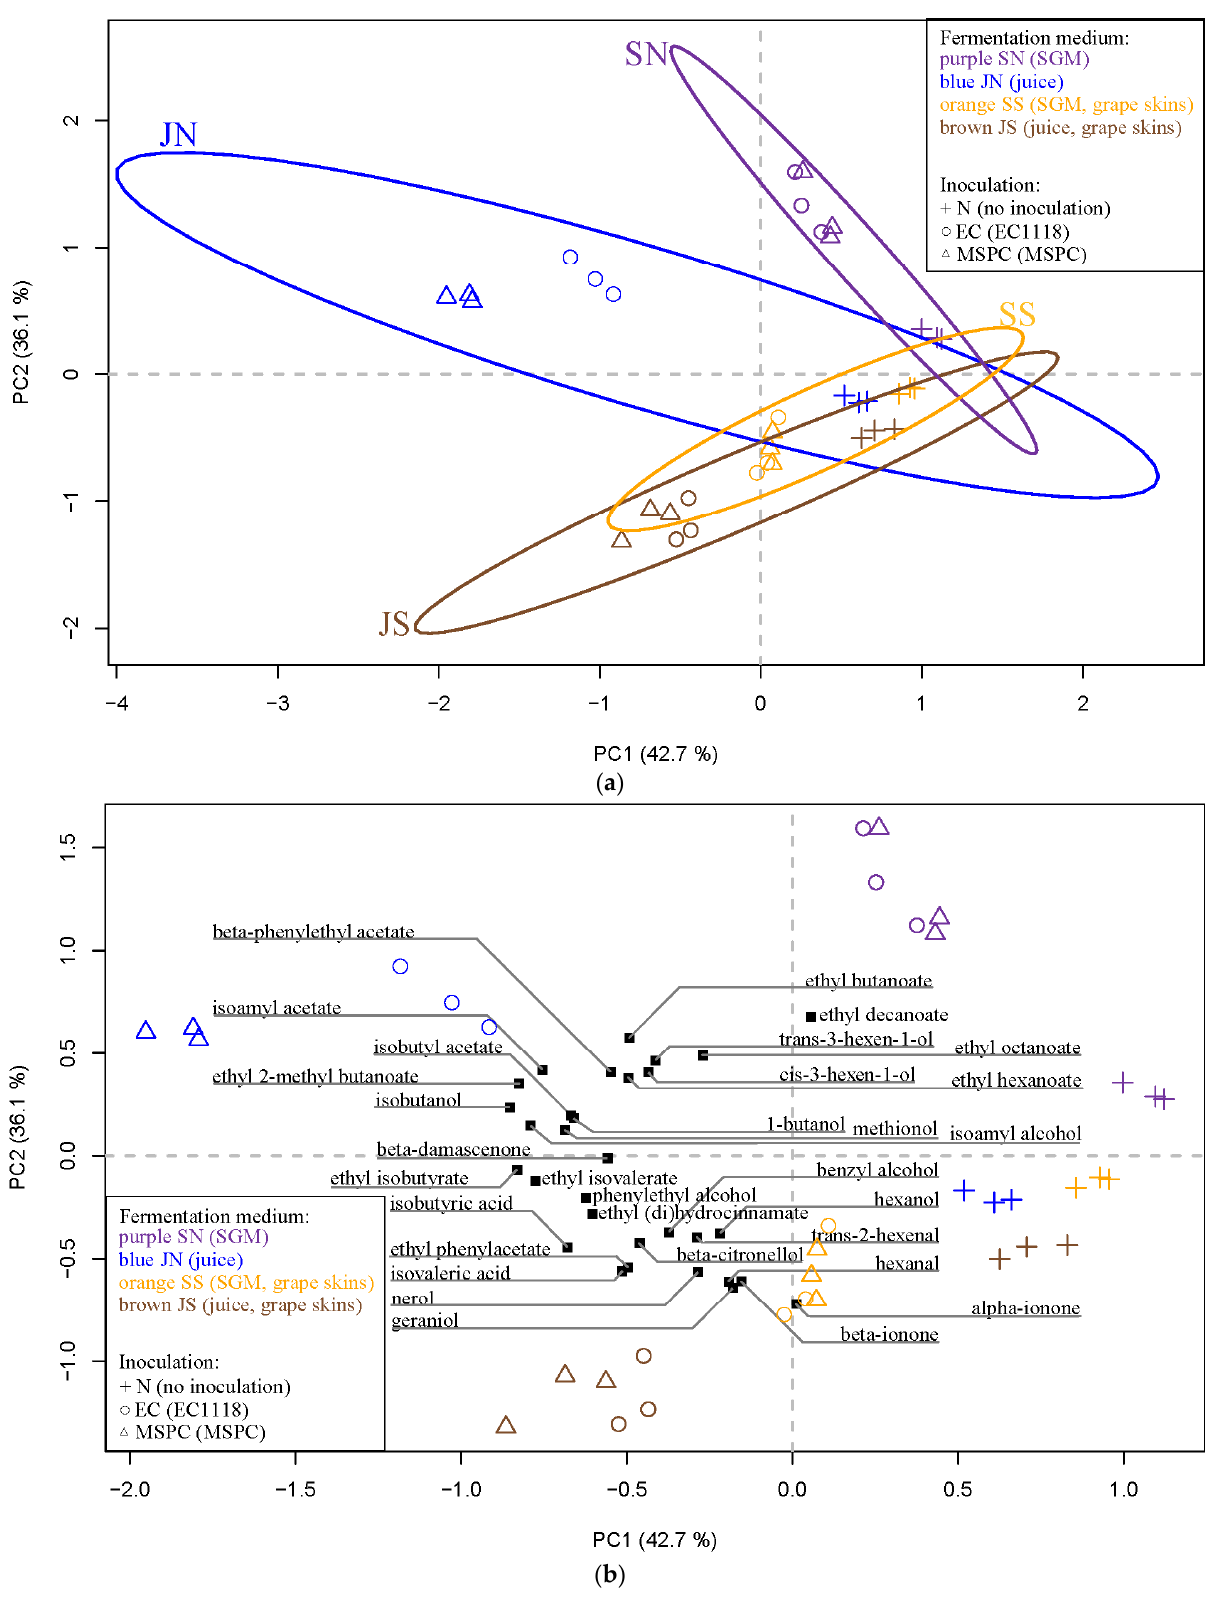
Figure 2. PCA biplots of principal component 1 (PC1) versus principal component 2 (PC2) of the fermentation samples showing the location of medium (JN, JS, SN, and SS) and inoculation treatments (EC, MSPC, and N) based on the wine volatile quantification results. Different symbols represent the medium and inoculum treatments; ( a ) circled by 95% confidence ellipses; ( b ) inclusion of volatiles determined to be important by Mardia’s Criterion.